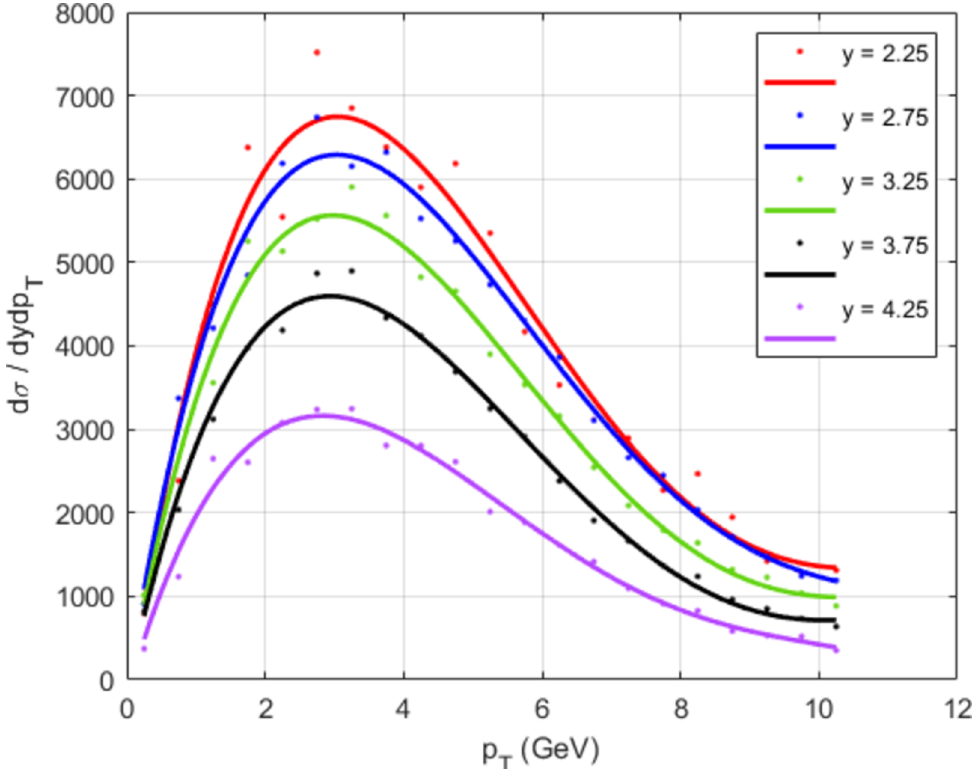
Figure 8 . Approximation to the beauty meson differential cross section (over rapidity y and transverse momentum p T ) we used to calculate the sgoldstino flux at